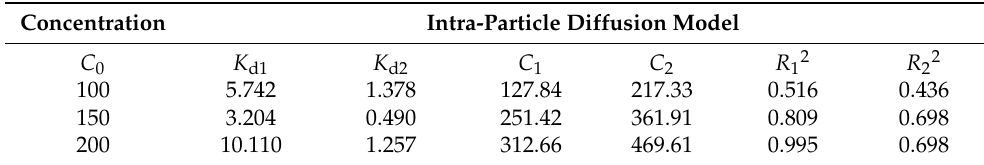
Table 3. Adsorption kinetic parameters of the intra-particle diffusion model for the adsorption of sulfonated lignite by filter paper-templated Mg-Al metal